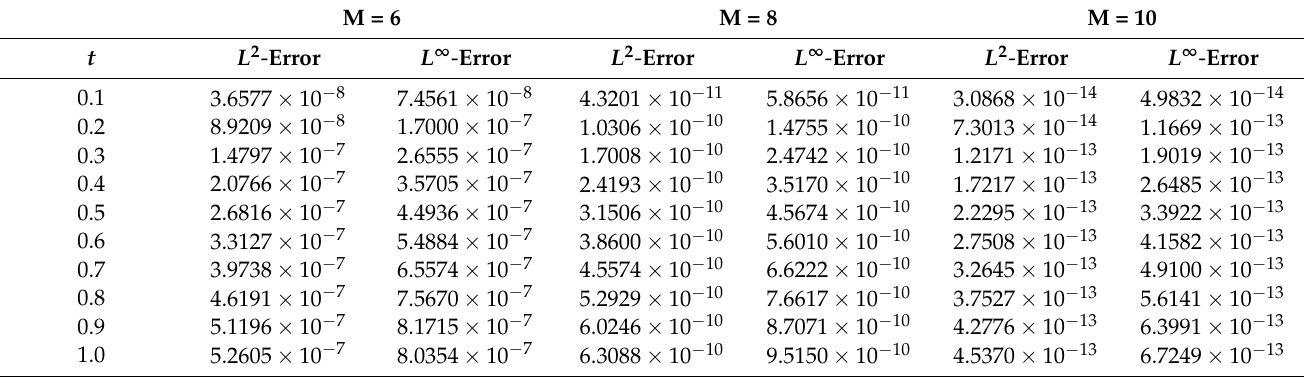
Table 7. Comparison of the L ∞ and L 2 errors at different times for Example